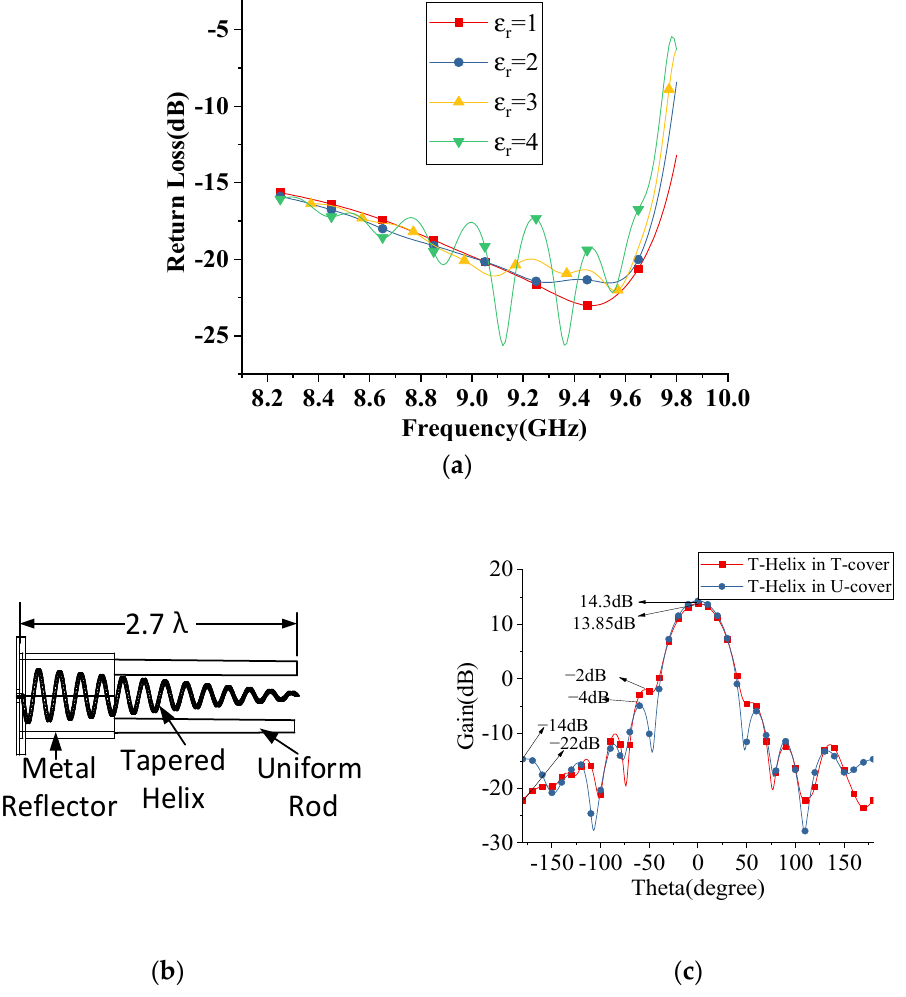
Figure 5. ( a ) Return loss of tapered helix antenna with covering of different dielectric constant ( b ) Schematic of Tapered-helix in Uniform cover ( c ) FBR with and without tapered dielectric cover.